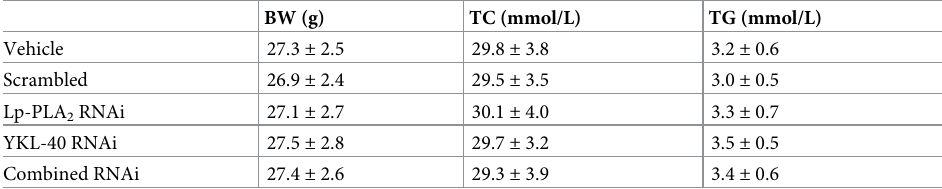
Table 1. Body weight, plasma TC and TG levels among all groups.